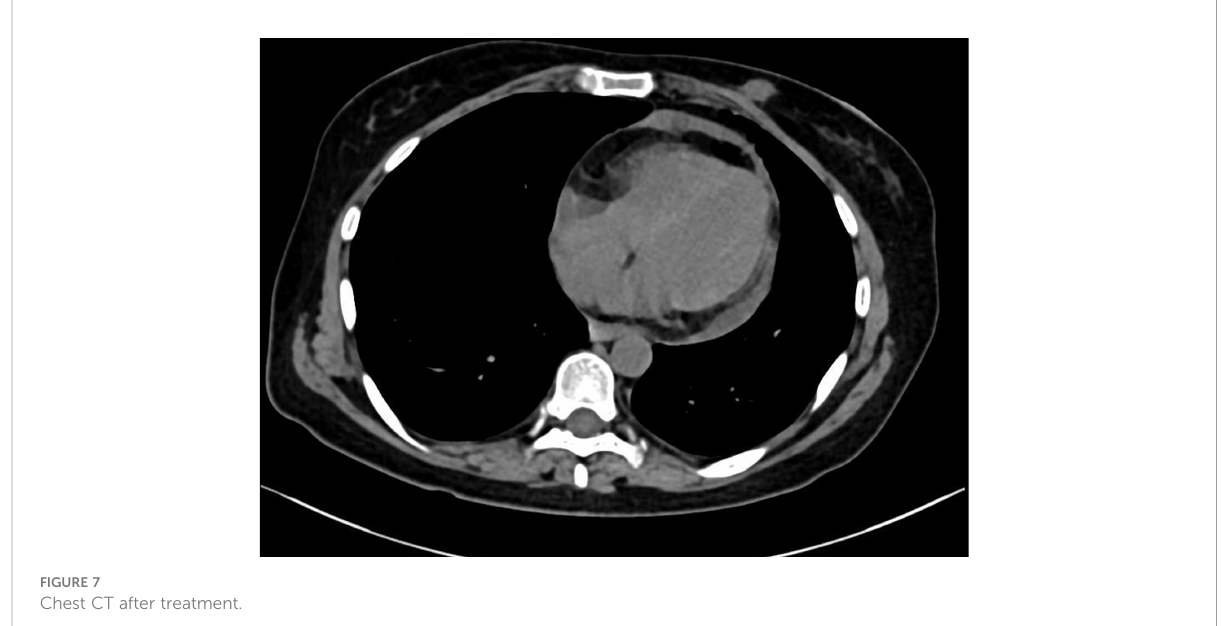
FIGURE 7 Chest CT after